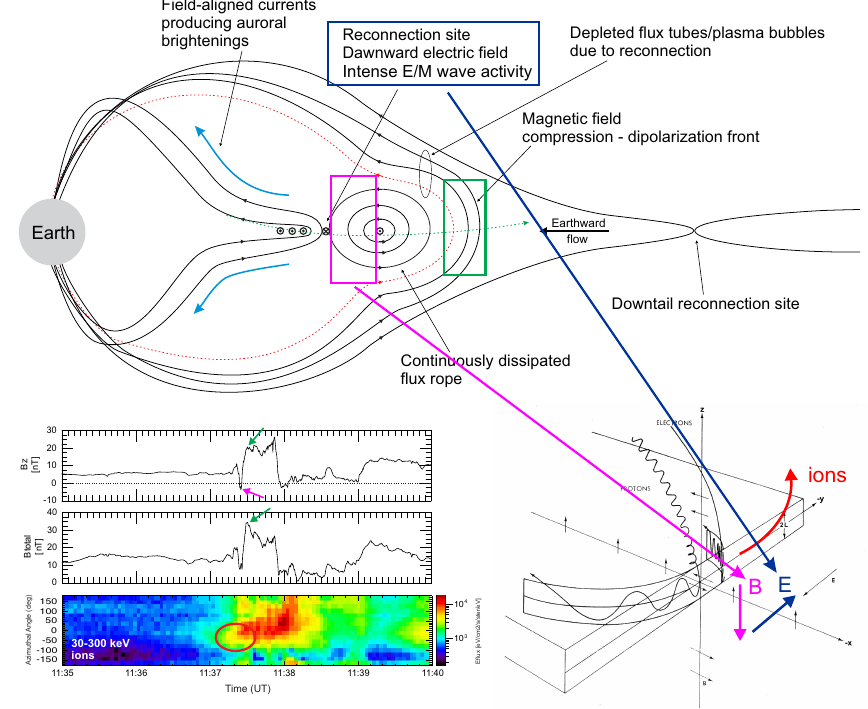
Figure 3. Synopsis of our interpretation in the context of the proposed model. Red oval denotes the earthward and dawnward injected energetic ions under the combined effect of a southward magnetic field and dawnward electric field. Key features of the interpretation are color coded. The bottom-right part of the figure is taken from Speiser